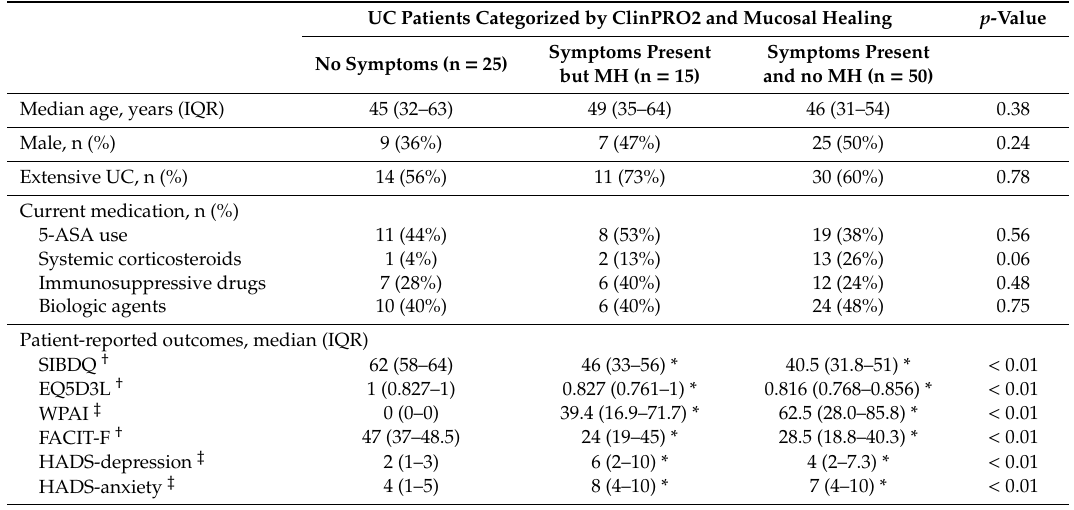
Table 3. PROs in UC patients categorized by ClinPRO2 and mucosal healing. UC Patients Categorized by ClinPRO2 and Mucosal Healing